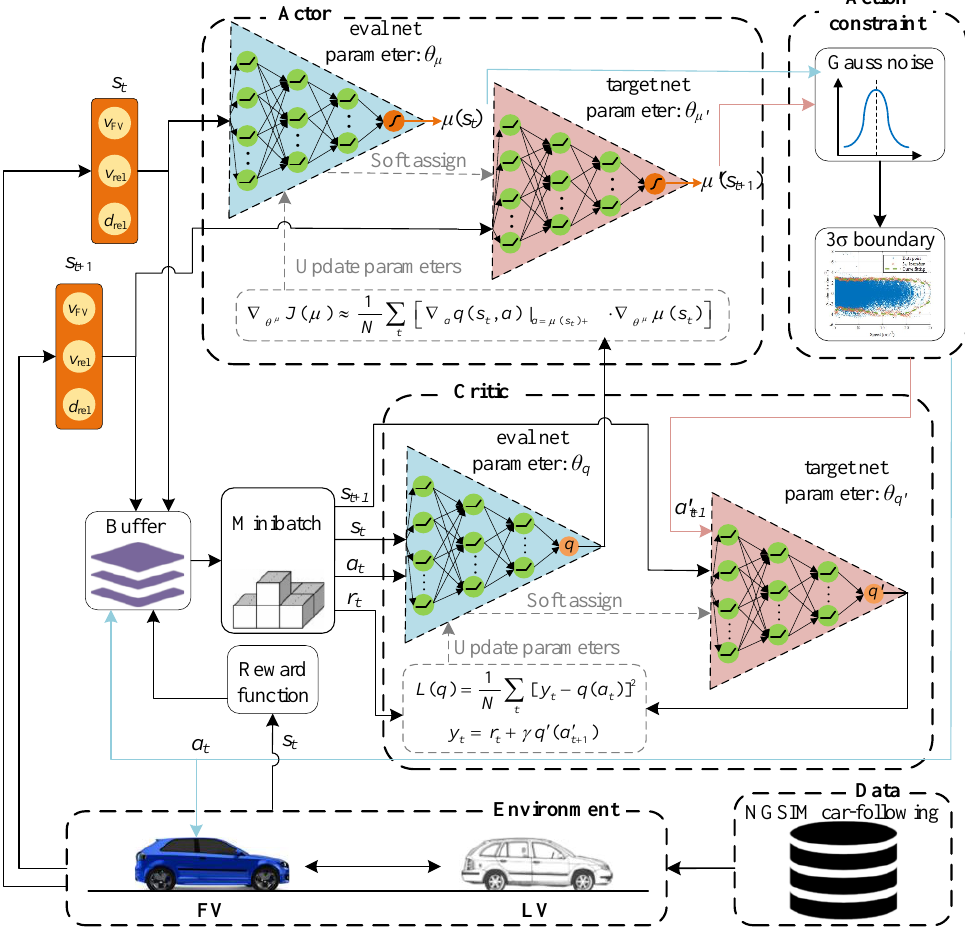
Figure 6. Agent-environment interaction model for autonomous car-following decision-making- based NGSIM data.